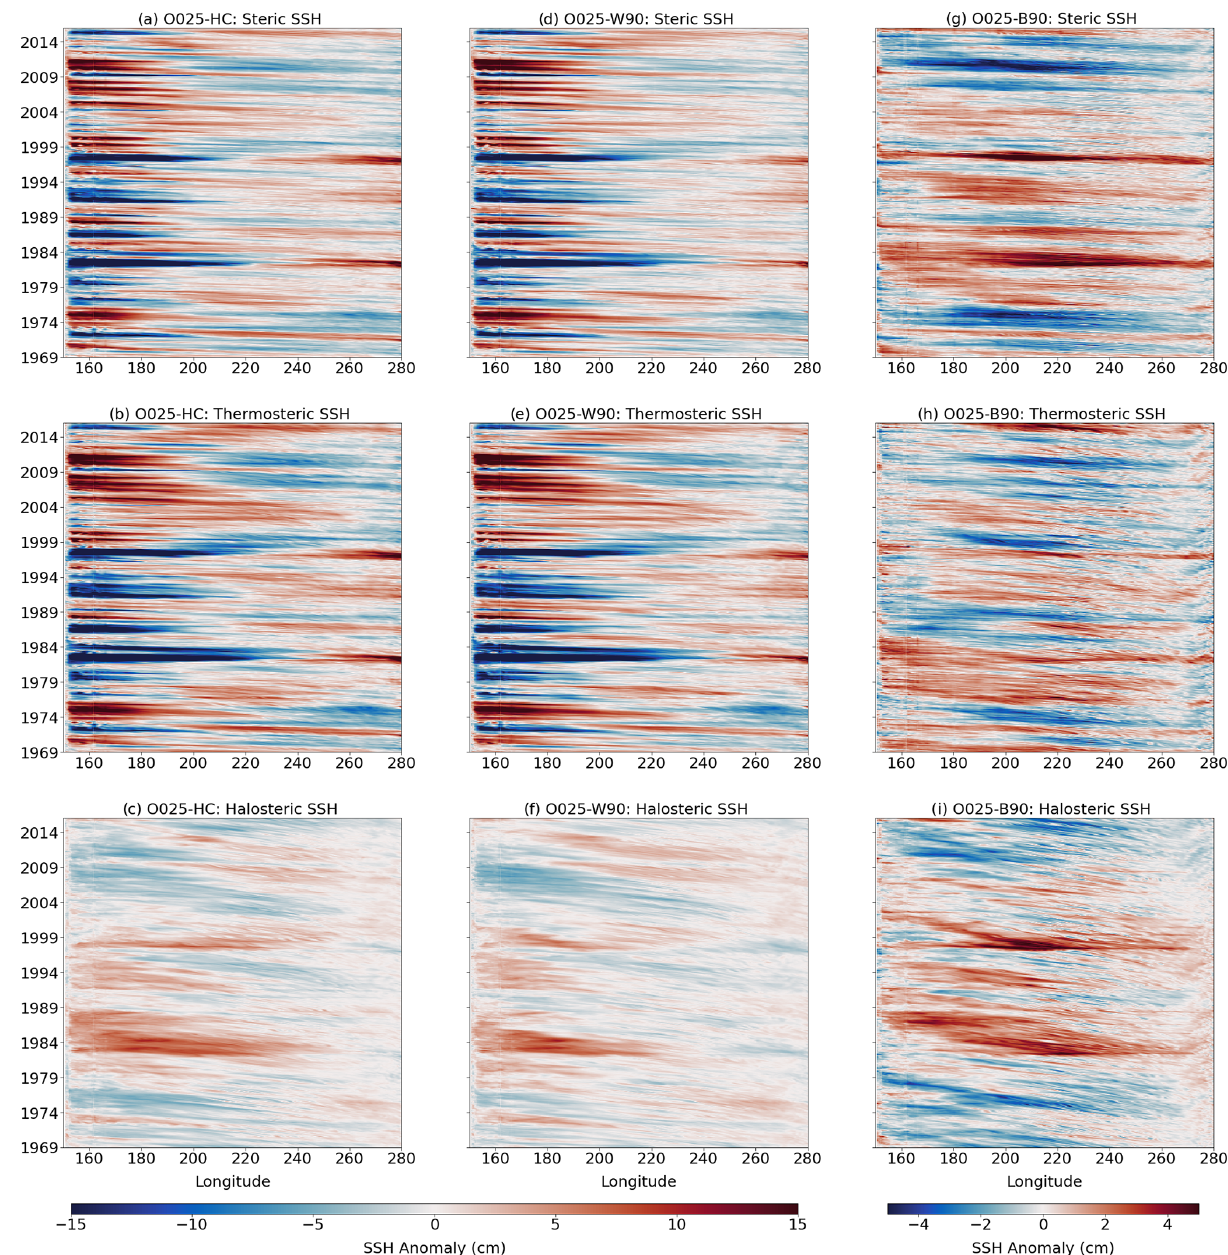
Figure 7. Hovmöller diagram of SSH anomalies at 10 ◦ S. Steric SSH (a, d, g) , thermosteric SSH (b, e, h) and halosteric SSH (c, f, i) from O025-HC (a, b, c) , O025-W90 (d, e, f) and O025-B90 (g, h, i) . All data have been smoothed with a 12-month running